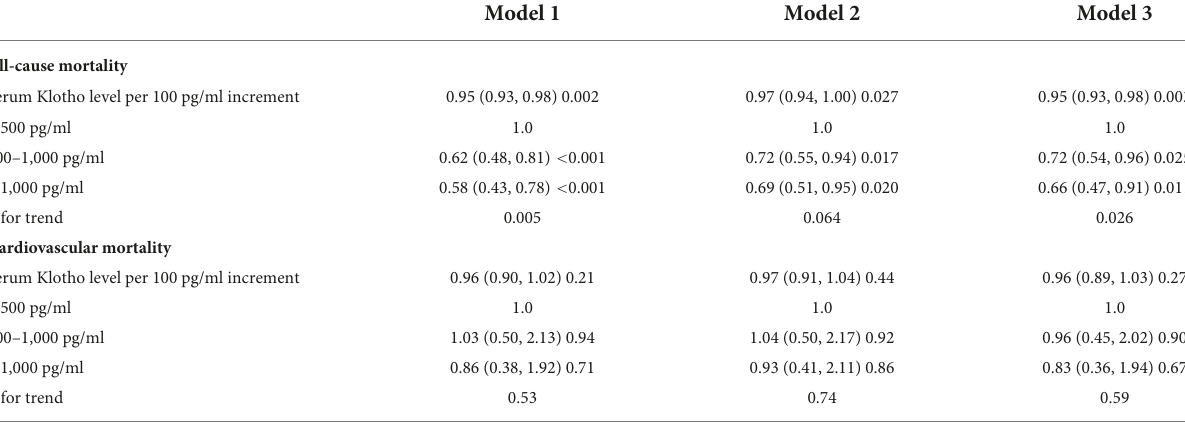
TABLE 2 Hazard ratios (95% CIs) for the association of serum Klotho concentrations with all-cause mortality and cardiovascular mortality in American hypertensive populations. Model 1 Model 2 Model